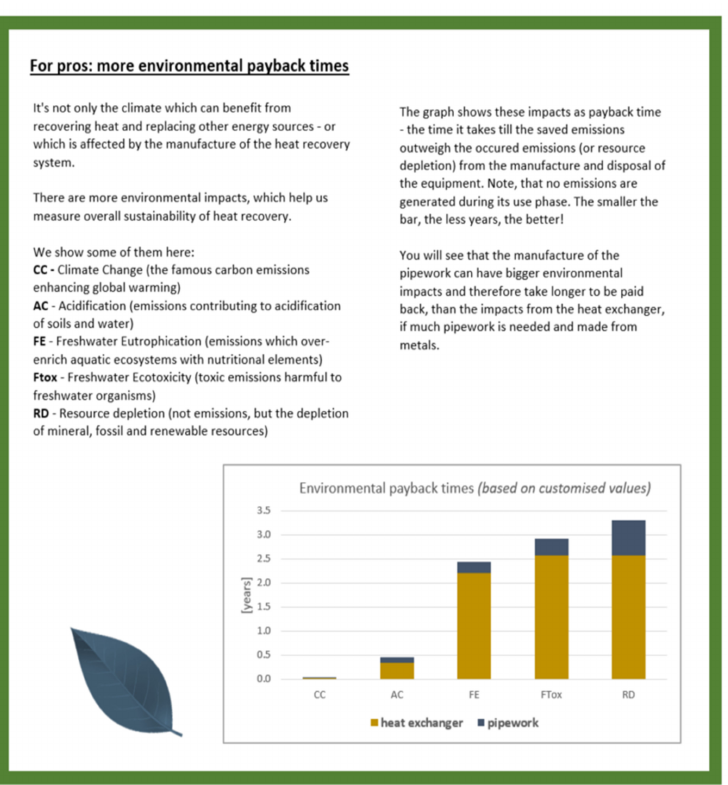
Figure 5. Example for results for payback time (in years) for carbon emissions and other environ- mental impacts of the heat recovery system, with a water consumption of 2000 m 3 /year, natural gas as replaced heating fuel, and 10 m pipework from steel. With graphical element modified from